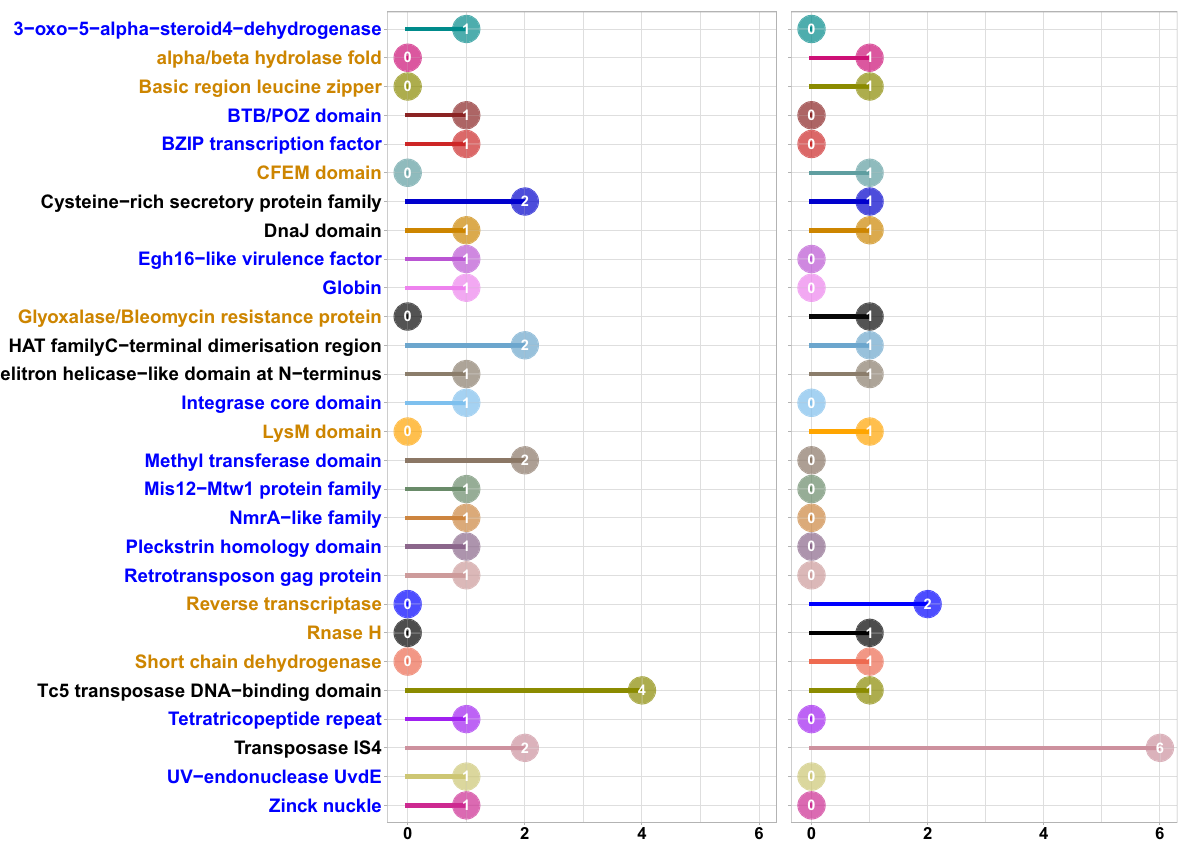
Figure 5. Predicted secreted effectors in the Foa formae speciales unique genome . The colors represent the predicted effector families and the numbers indicate the count of effectors in each family for each Foa